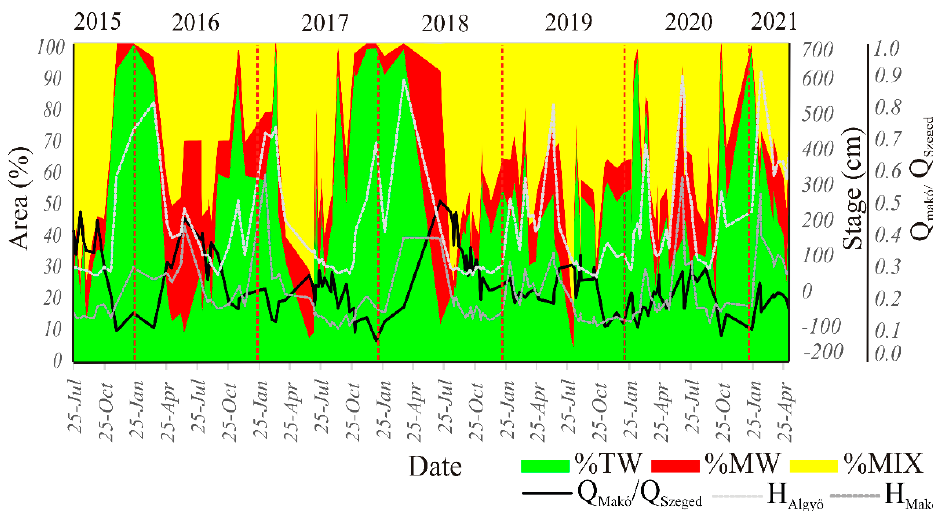
Figure 5. Areal distribution (%) of Tisza water (TW), Maros water (MW), and their mixed water (MIX) in the entire confluence area based on the acquisition of 143 Sentinel ‐ 2 images. The main characteristics of the concurrent rivers are also indicated.